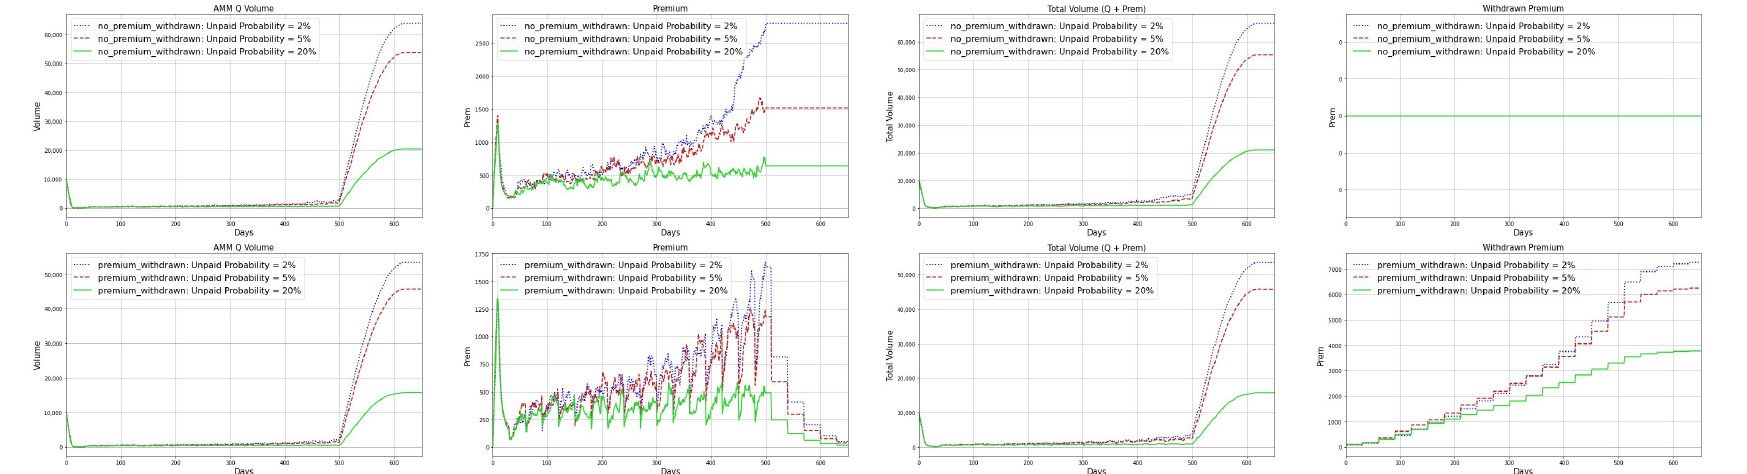
Figure A5. rkAMM Curves from simulation of scenario 2 and 30 days of withdrawal period.